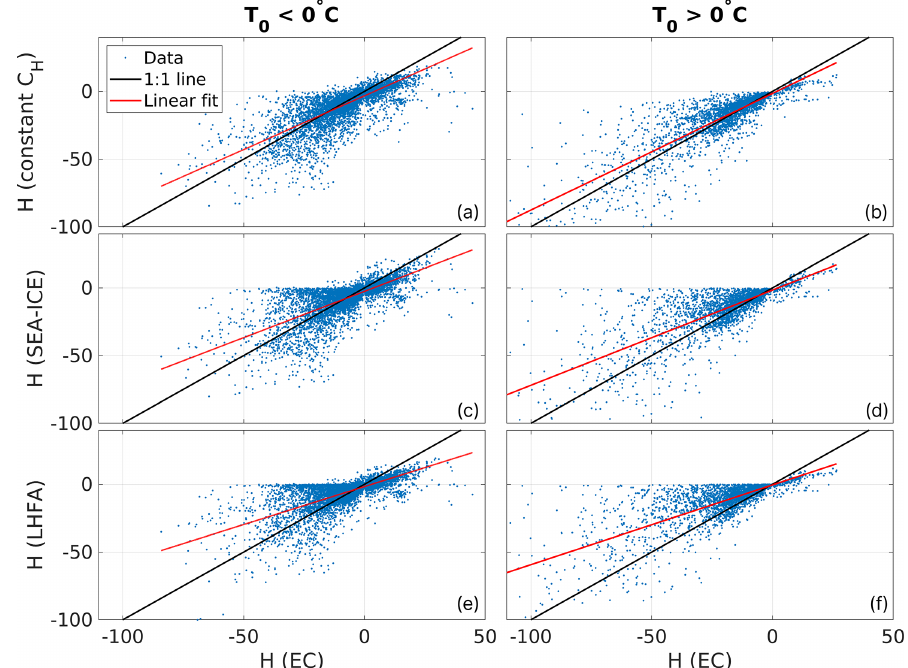
Figure 6. Scatter plots of the 30min sensible heat flux values of the three included models against corresponding EC measurements. All the axes have a unit of Wm − 2 . Black line indicates a 1 : 1 fit and red line the best linear fit. Linear fit parameters are listed in Table 2.